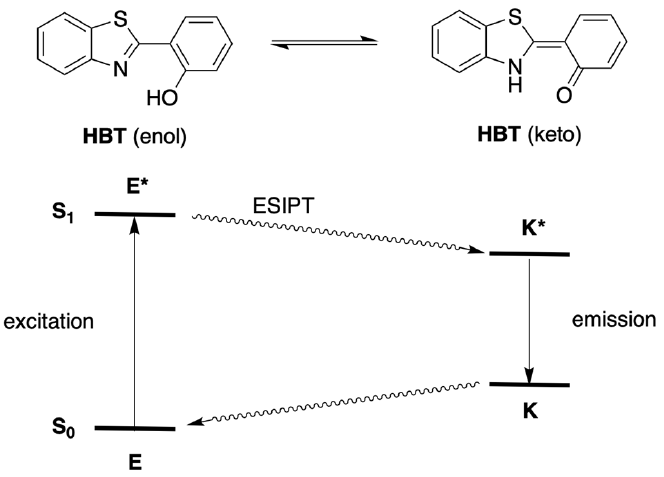
(Figure 2) [30,32,33].